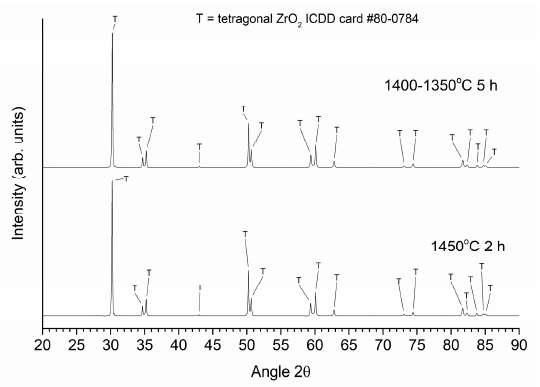
Figure 14. XRD patterns of a conventionally sintered sample and a two-step sintered sample (T1 = 1400 ◦ C, T2 = 1350 ◦ C, t2 = 5 h), both prepared using ball milled powder.